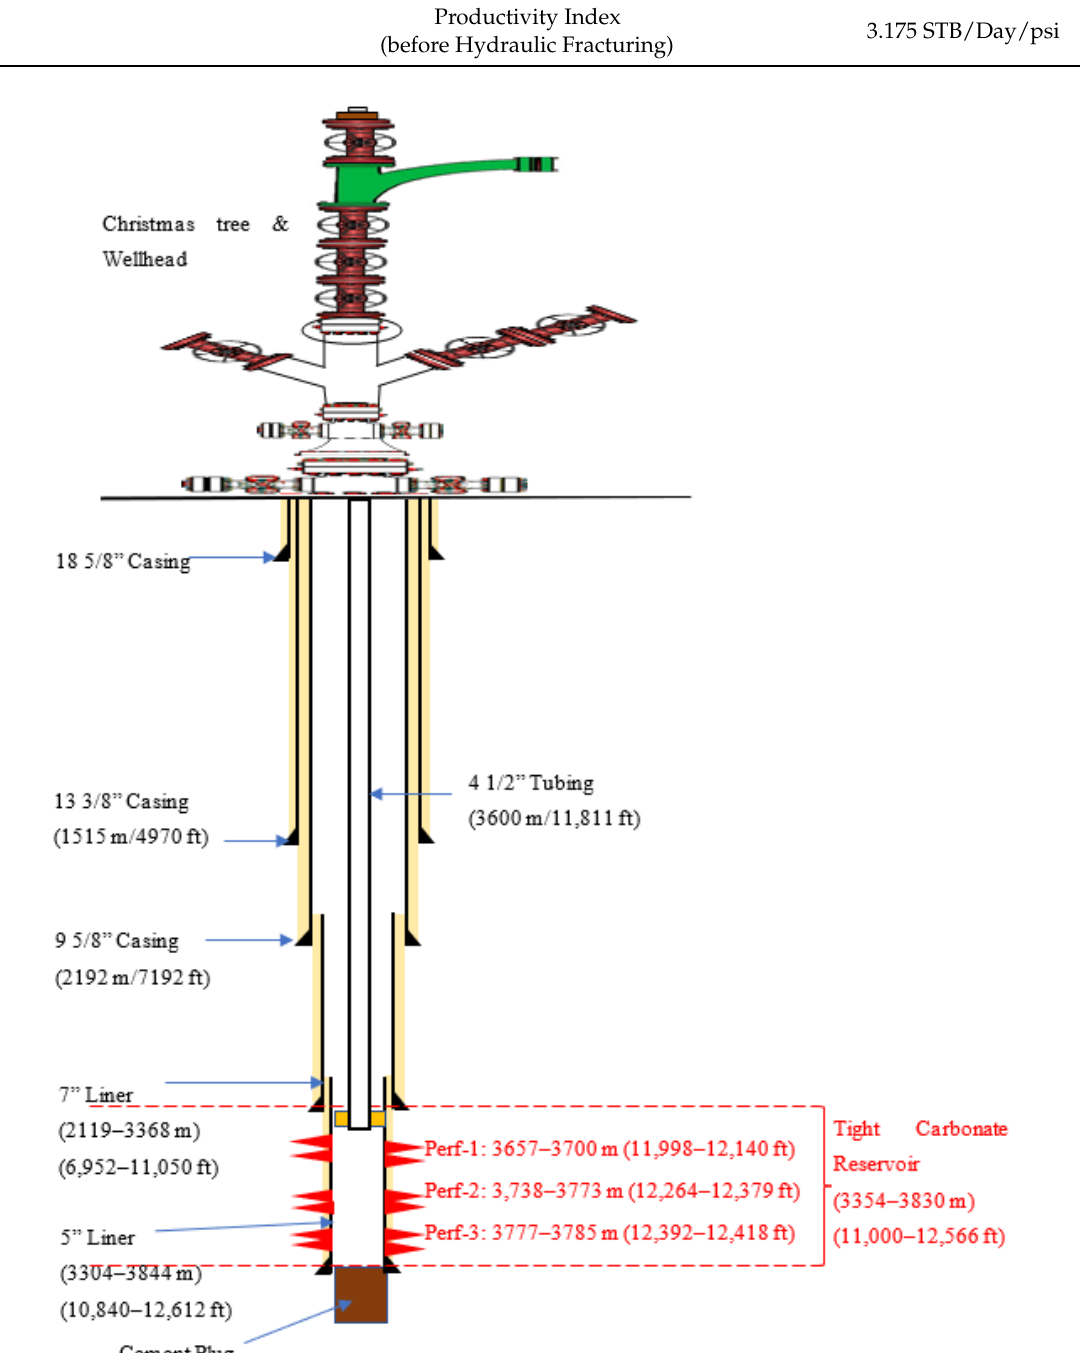
Figure 1. Well schematic with indicated tight carbonate reservoir and perforations intervals.